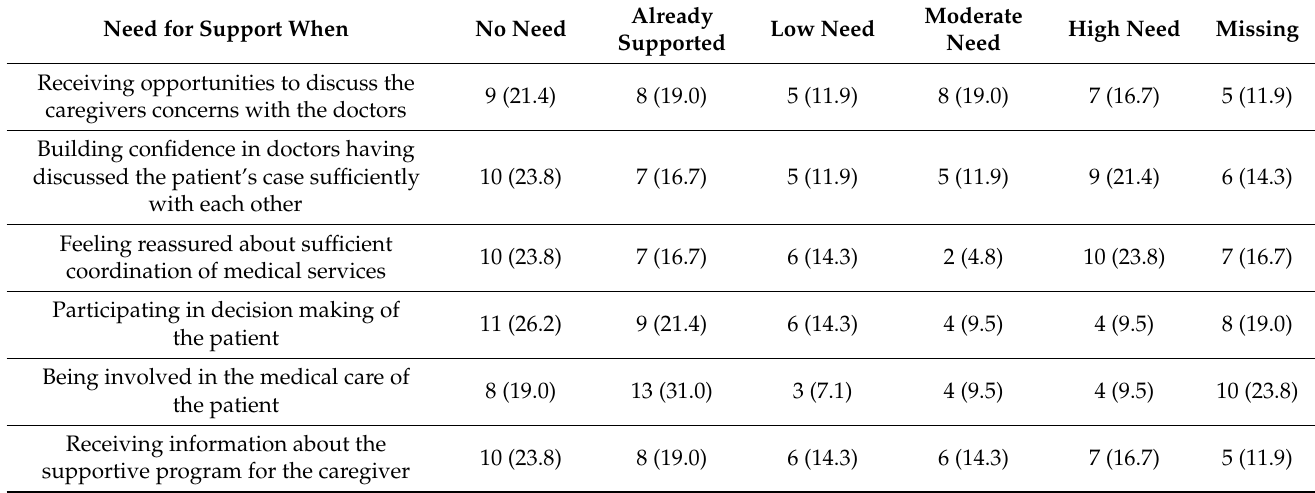
Table 5. Hospital coordination, with data in total number ( n ) and percentage (%) for categorical